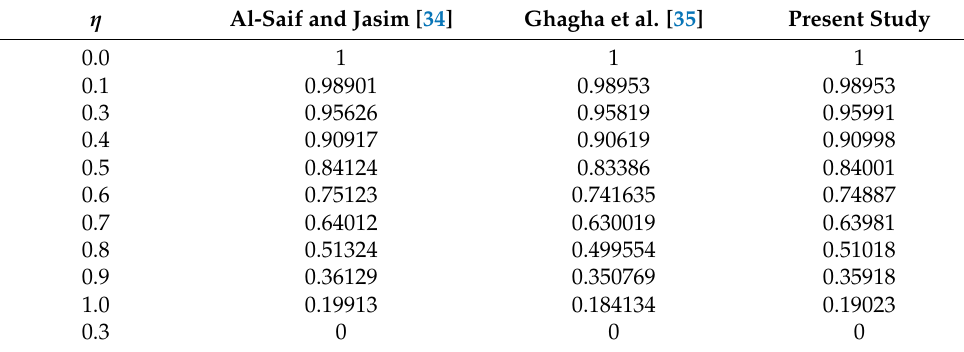
Table 2. Comparison of numerical values of skin friction f η ( 1 ) against multiples values of the parameters and an opening angle ψ , when Re = 50, We = 1.0, Γ = 0 or n = 1. f ( 1 ) η α Alam et al. [21] Rehman et al. [36]